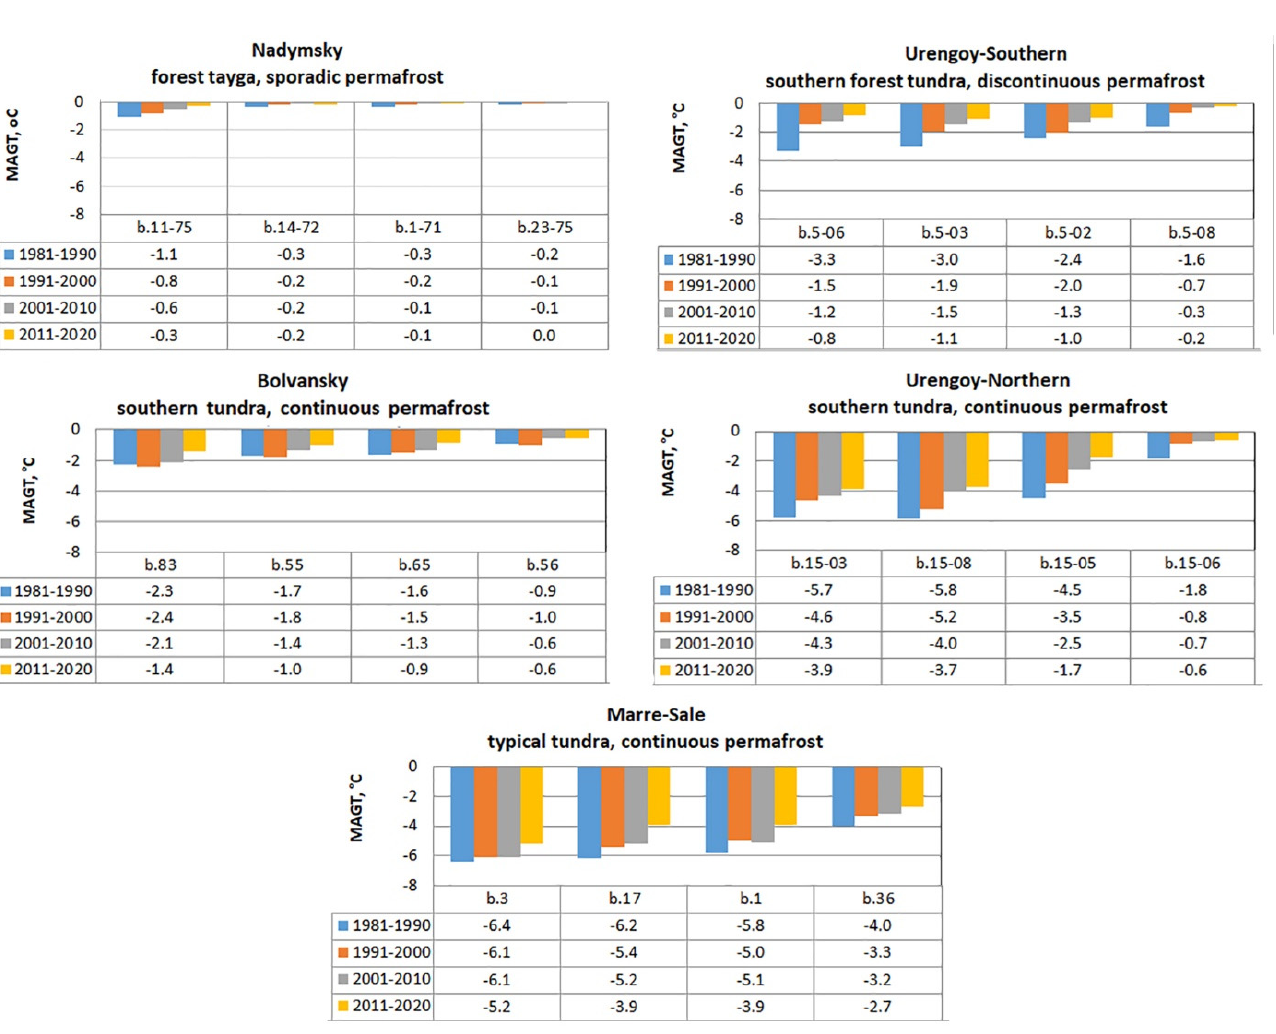
Figure 6. Mean annual ground temperature in boreholes averaged over decades at a depth of 10 m in typical cryogenic landscapes at geocryological stations.